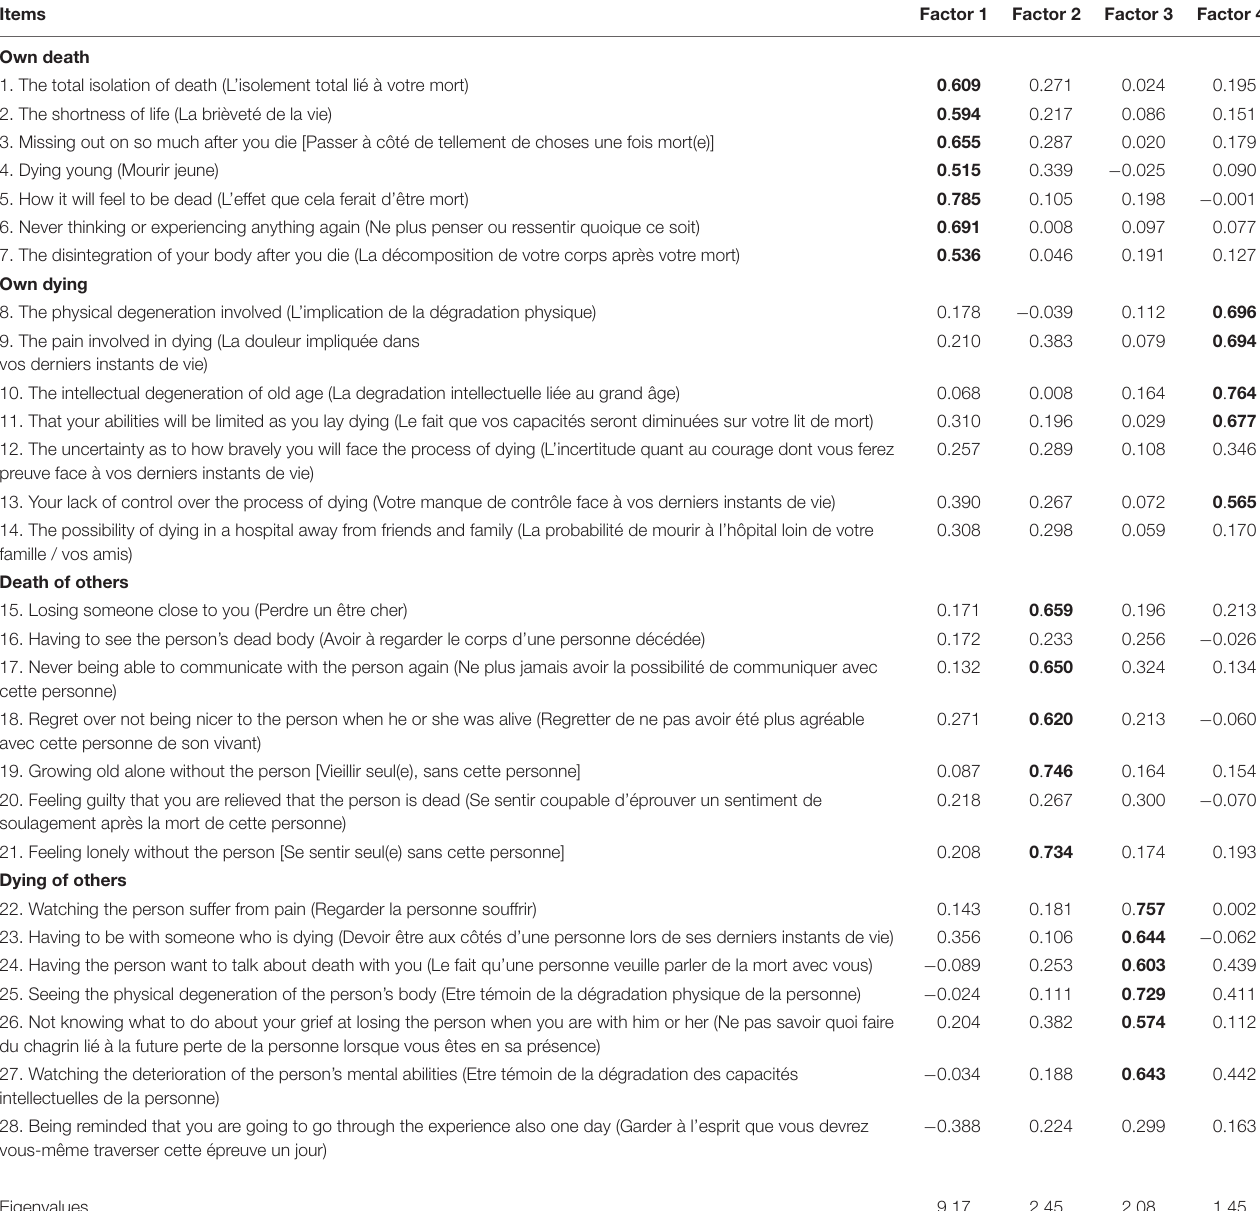
TABLE 2 | Rotated Factor loading for the revised Collett–Lester fear of death scale (EFA – n = 207).